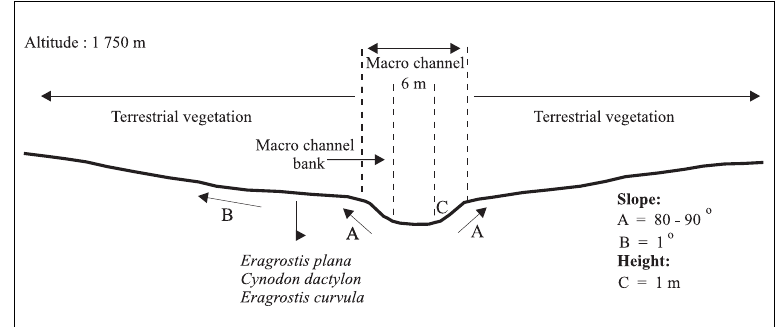
Fig. 2. River profile of the Eragrostis plana-Monopsis decipiens